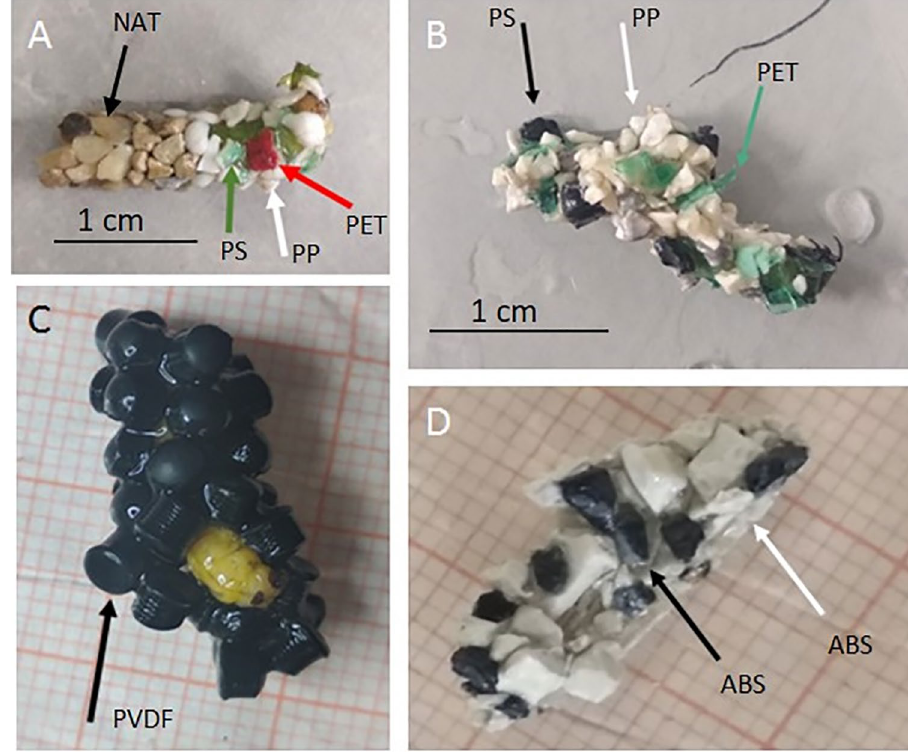
Figure 4. Artificial cases built by caddisfly larvae in indoor experiments using different substrates: ( A ) MIX = natural substrate (NAT) and lMP (50% each); ( B ) lMP = PET, PP, PS (in equal proportions); ( C ) PVDF = polyvinylidene fluoride; and ( D ) ABS = acrylonitrile butadiene styrene. The arrows indicate different substrates. The images ( A ), ( B ), ( C ) and ( D ) are obtained by the software PowerPoint (ver. 2002, https ://www. micro soft.com/it-it/micro soft-365/power point ).